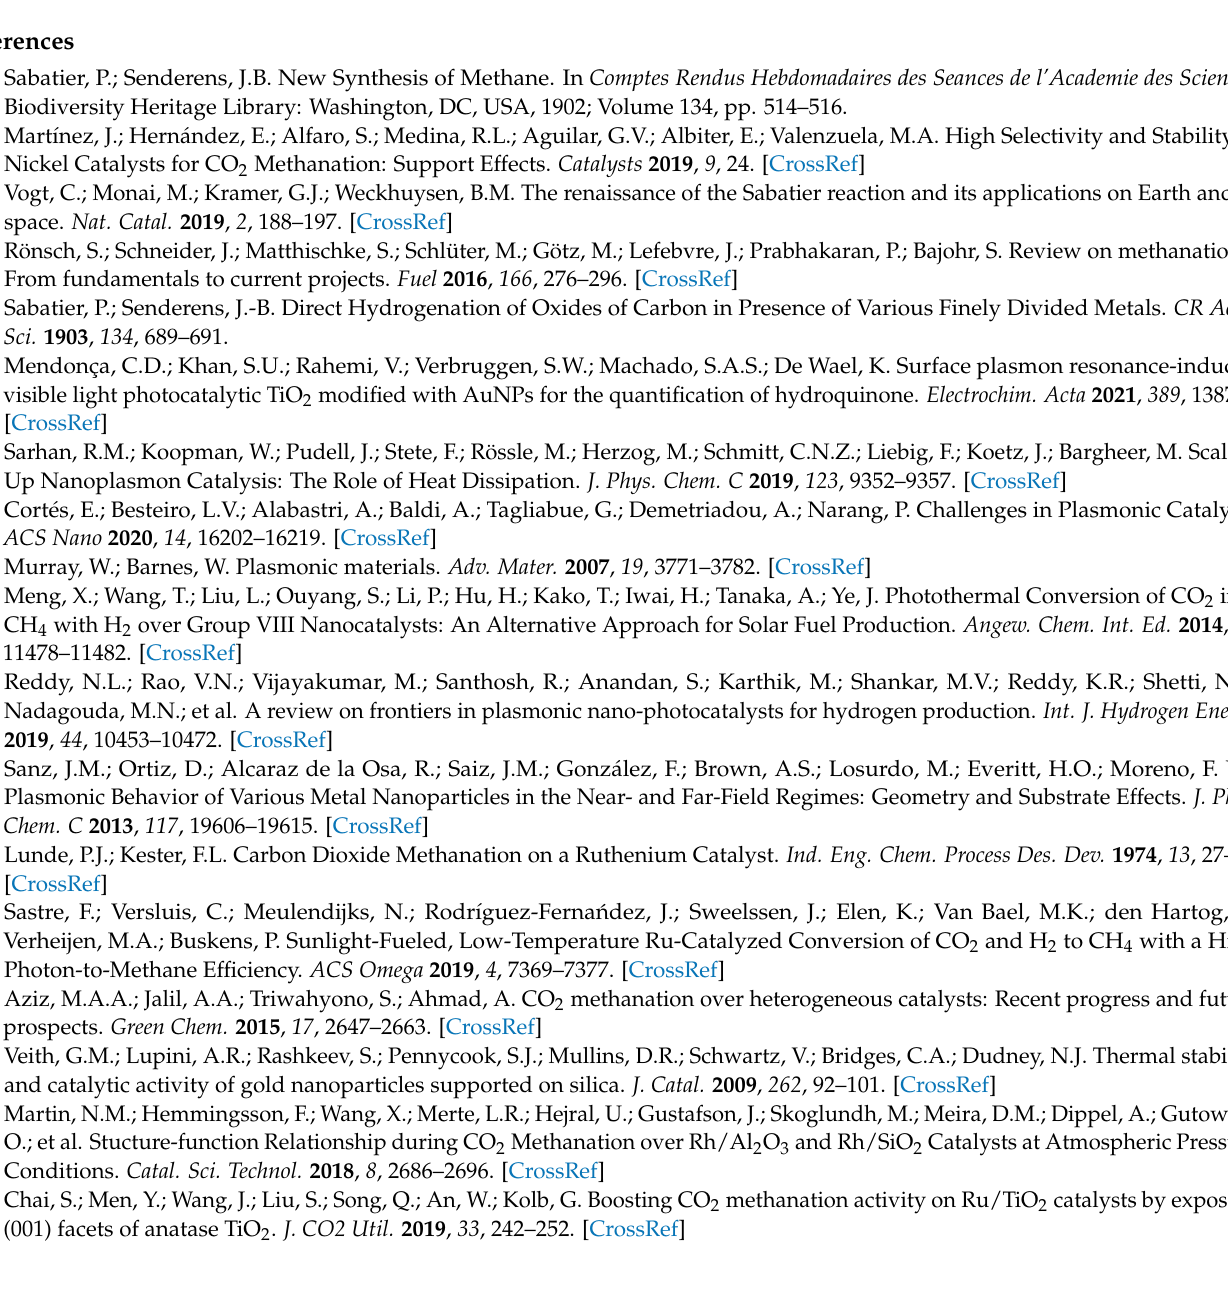
Figure S6: Prototypical gas chromatogram for catalytic conversion of CO 2 and H2 to CH 4 in a mixture diluted with